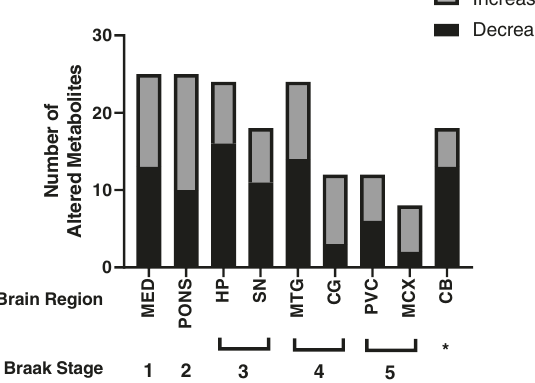
Fig. 1 Number of altered metabolites in PDD brain regions. CB cerebellum, CG cingulate gyrus, HP hippocampus, MCX motor cortex, MED medulla oblongata, MTG middle temporal gyrus, PVC primary visual cortex, SN substantia nigra. *CB is typically considered unaffected in α -synuclein Braak